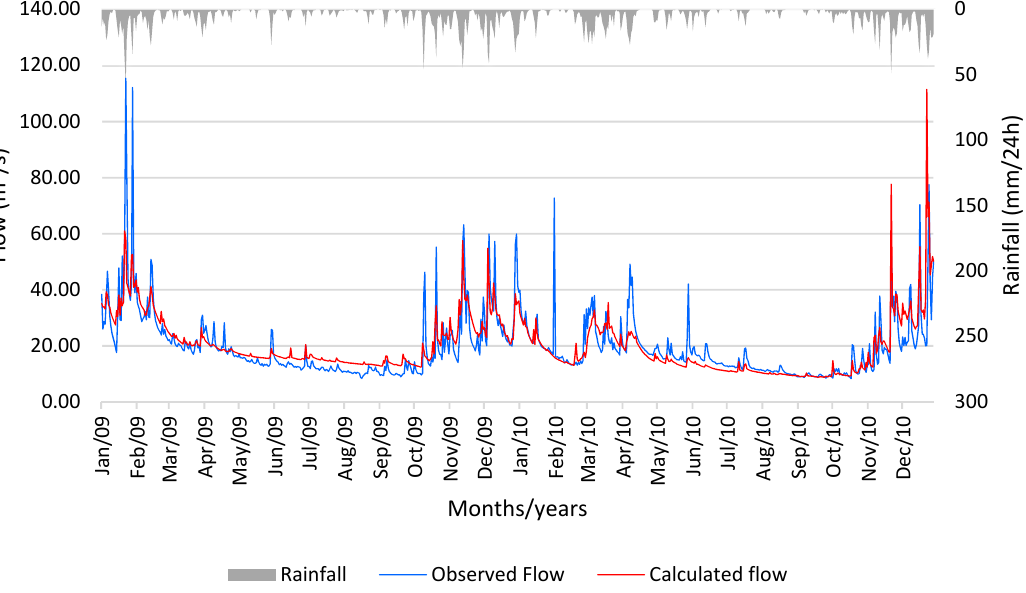
Figure 8. Calibrated comparison between estimated flow and simulated flow in SWAT defined by the left axis, while the right axis represents daily precipitation.